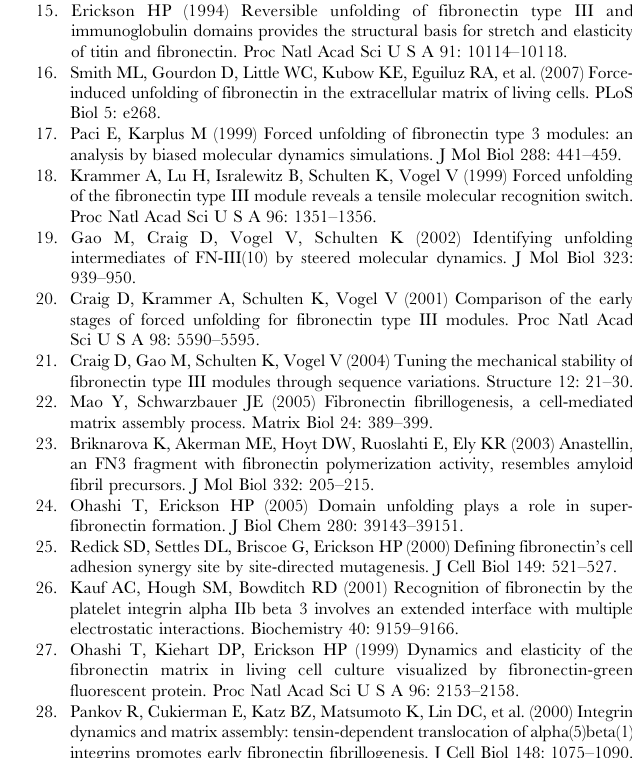
Movie S2 Partial N-to-C Unfolding, Group 2. The anchor and pulling points are highlighted as black spheres with pulling towards the right. Initial unfolding of 10FNIII occurs at both the N- and C- termini. Movie S3 Partial N-to-RGD Unfolding. The anchor and pulling points are highlighted as black spheres with pulling towards the right. Initial unfolding of 10FNIII occurs exclusively at the N- terminus. The central glycine is labeled with a magenta sphere while Arg1445 is highlighted with a gold sphere. Note that the separation of these two residues increases following the occurrence of the kinetic intermediate (paused